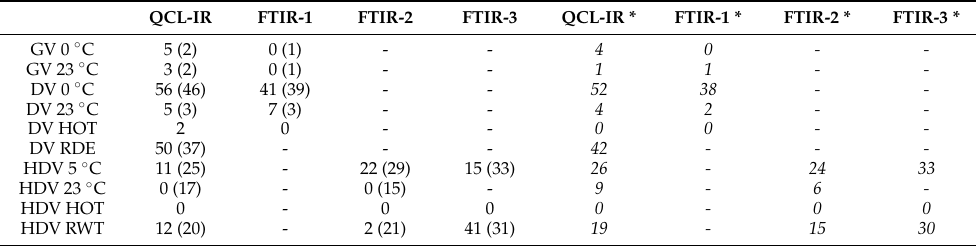
Table 2. Total HCHO emissions (mg) during the WLTC tests performed with GV and DV, the WHVC tests performed with HDV and the RDE and RWT tests performed with DV and HDV, respectively. The values in brackets correspond to the HCHO (mg) measured in the first 400 s of the tests for the GV and the DV. Italic text is used to indicate the values that were calculated applying a threshold on the measured concentrations corresponding (QCL-IR, 0.2 ppm; FTIR-1, 1.8 ppm; FTIR-2, 0.6 ppm and FTIR-3, 0.3 ppm—see Section